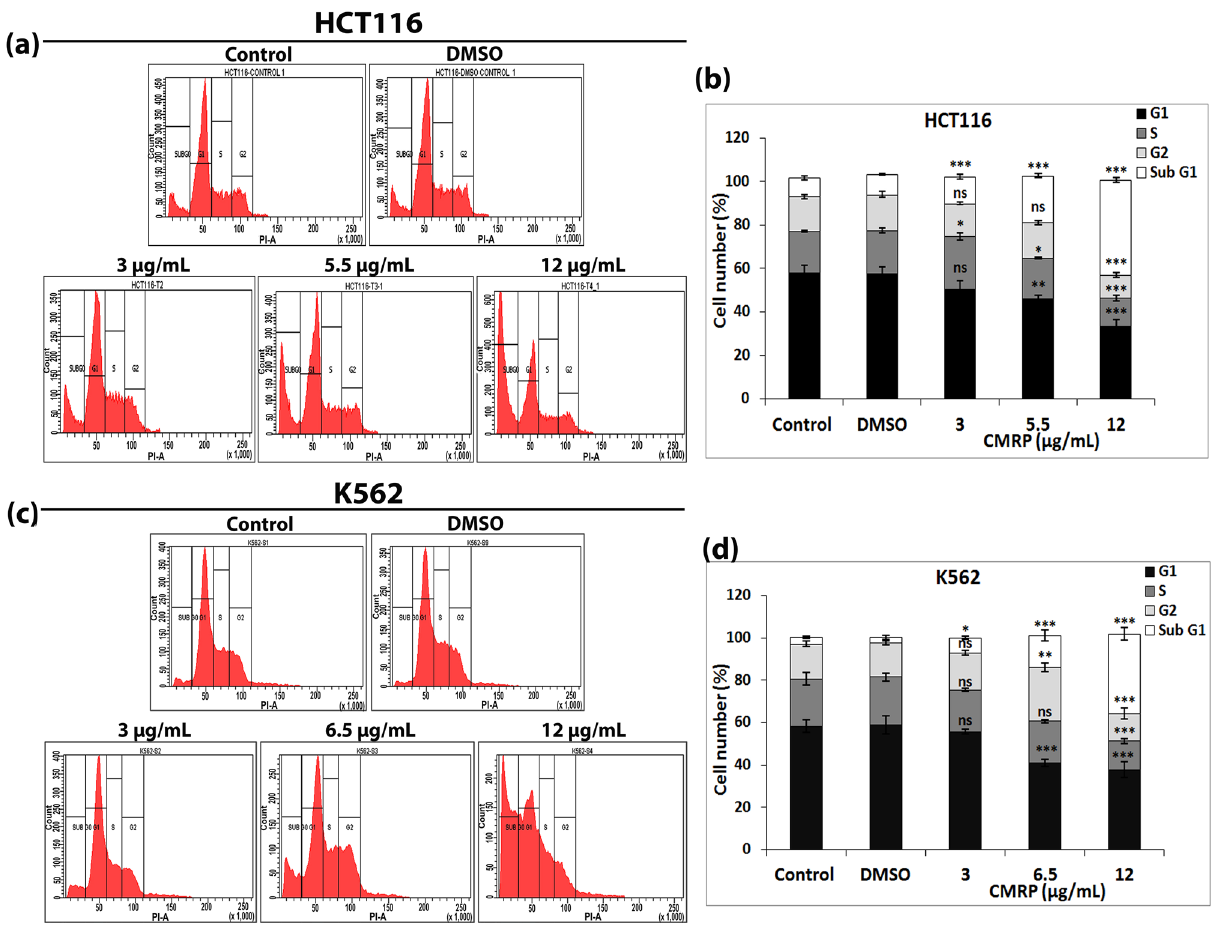
Figure 6. Effect of CMRP on cell cycle phase-specific distribution of cancer cells. ( a ) and ( c ) Flow cytometric analysis of cell cycle phase-specific distribution, following 24 h treatment with CMRP against HCT116 and K562 cells respectively. ( b ) and ( d ) Bar diagrams showing percentage of cells in different phases (G1, S, G2 and sub G1) of cell cycle of HCT116 and K562. Ns—not significant, * P < 0.05, ** P < 0.01, *** P <